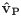
A scatter plot of the natural log of BPND and RNM.The star corresponds to the mean ln(BPND) and ln(RNM) of all subjects and the arrows, v^P and v^N, are the basis vectors obtained from the PCA.